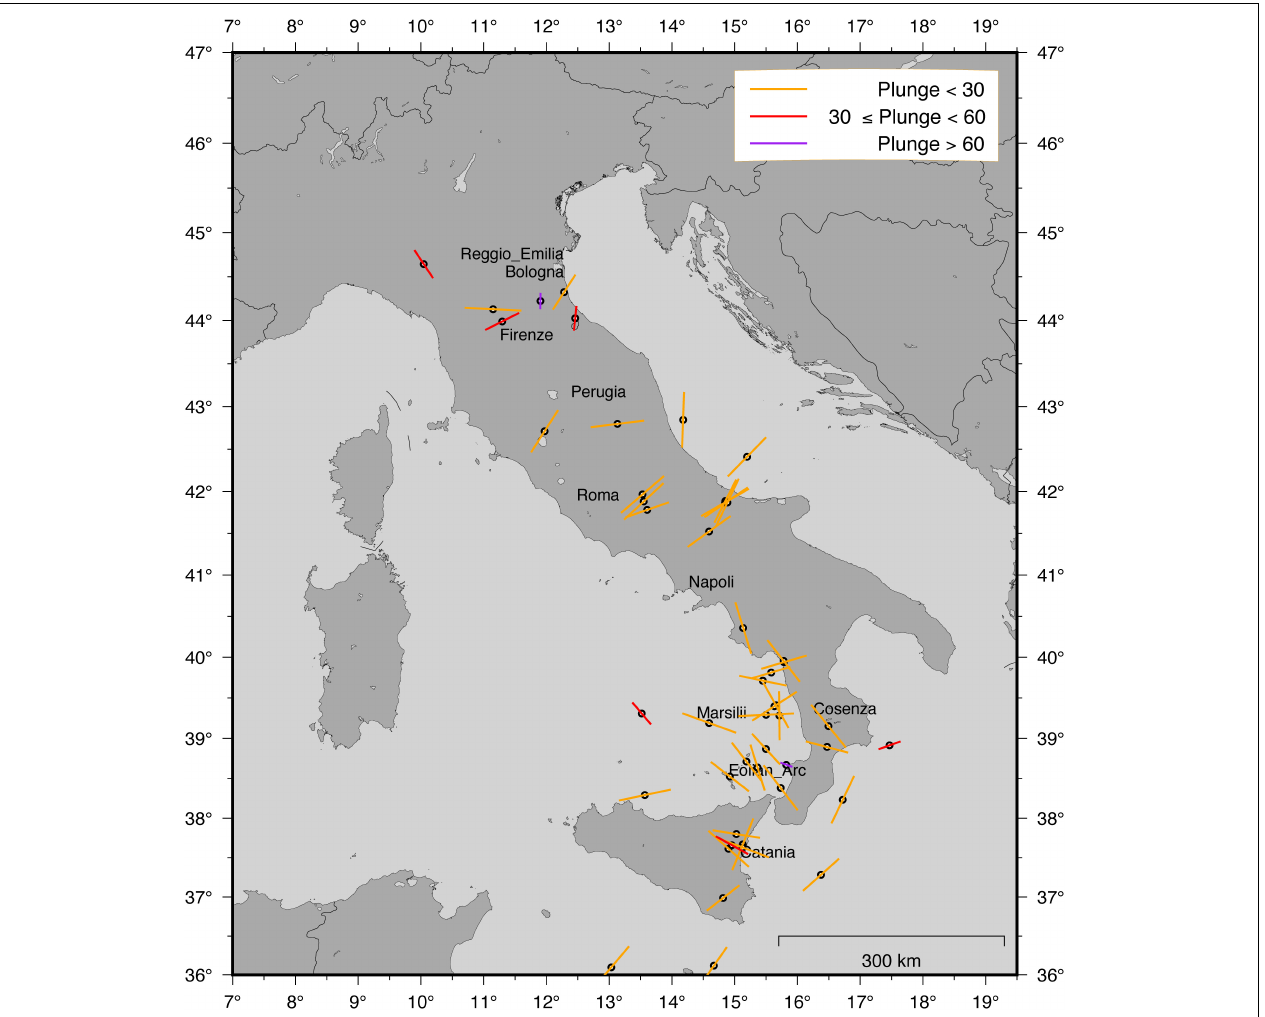
FIGURE 7 | T -axes of focal mechanism solutions determined in the present study for “Italy” area. The length of each bar is inverse proportional to the plunge of the axis; colors are related to the 3 groups of plunges reported in the